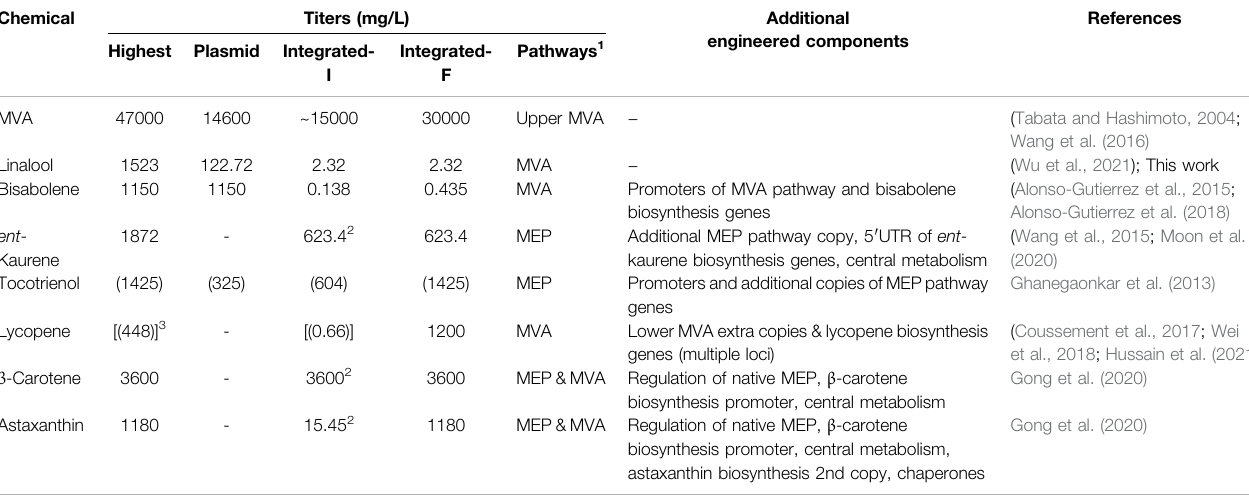
TABLE 2 | Comparison of published recombinant terpene pathway-based precursor and product titres from plasmid-based and genomic integrated strains. Chemical Titers (mg/L) Additional engineered